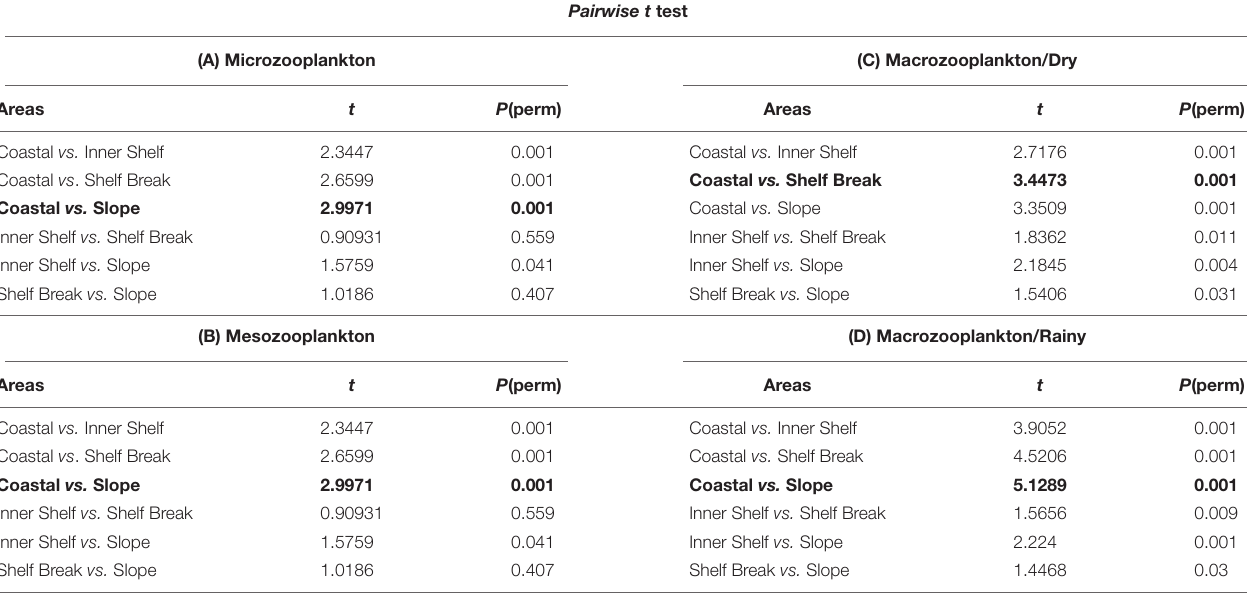
TABLE 4 | Results of pairwise t test of the micro- meso- and macrozooplankton community structure considering area and season as